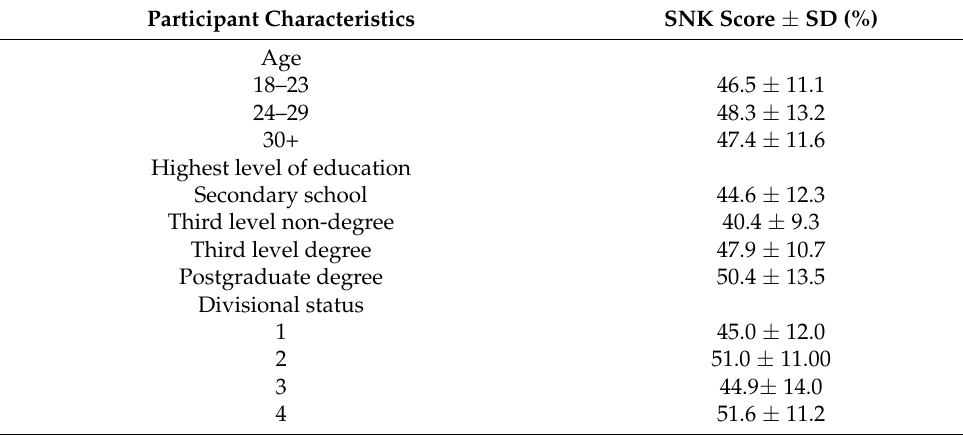
Table 3. Demographic characteristics and sports nutrition knowledge of elite Gaelic football players ( n =